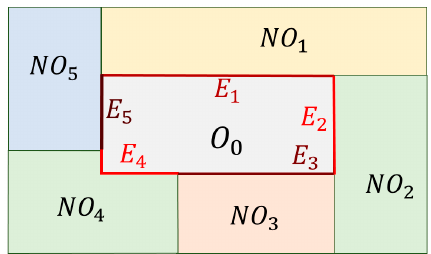
Figure 5. Relationship between an object O 0 and its neighbors. Here, O 0 has five topologically neighboring objects, NO i (1 ≤ i ≤ 5 ) represents the i -th neighbor of O 0 , and E i denotes the common boundary length between O 0 and NO i ( E 1 > E 3 > E 2 > E 4 > E 5 ). Remote Sens. 2018 , 10 , x FOR PEER REVIEW